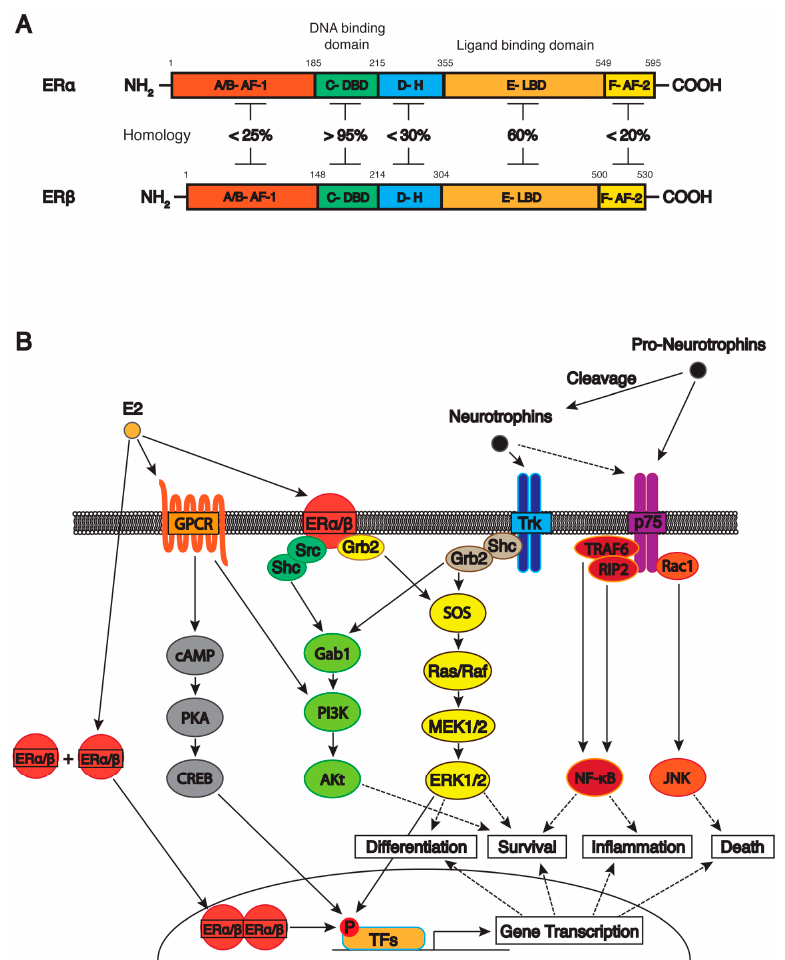
Figure 1. ( A ) Estrogen receptor structure and function. Homology between ER α and ER β : amino acid identity (%) in the N-terminal activation function 1 region (AF-1), DNA-binding domain (DBD), hinge region (H), ligand-binding domain (LBD), and C-terminal function 2 domain (AF-2); ( B ) interaction of neurotrophin receptor and estrogen signaling pathways. Schematic outlining of the neurotrophin receptors and their associated peptides and a simplified diagram describing the main signaling pathways activated by the Trk and p75 receptors. Activation and subsequent phosphorylation of the Trk receptor results in the activation of the MEK/ERK signaling pathway, that leads to phosphorylation of transcription factors (TFs) like CREB and promotes cell differentiation and survival; and the PI3K/Akt pathway that promotes cell survival. The p75NTR signals modulate the NF- κ B and JNK pathways, which promotes inflammation and cell survival or apoptosis respectively. The classical and non-classical estrogen pathway interacts with neurotrophin system and regulates neuronal survival and ameliorative effects on the BFCN. Dashed arrows indicate various targets.